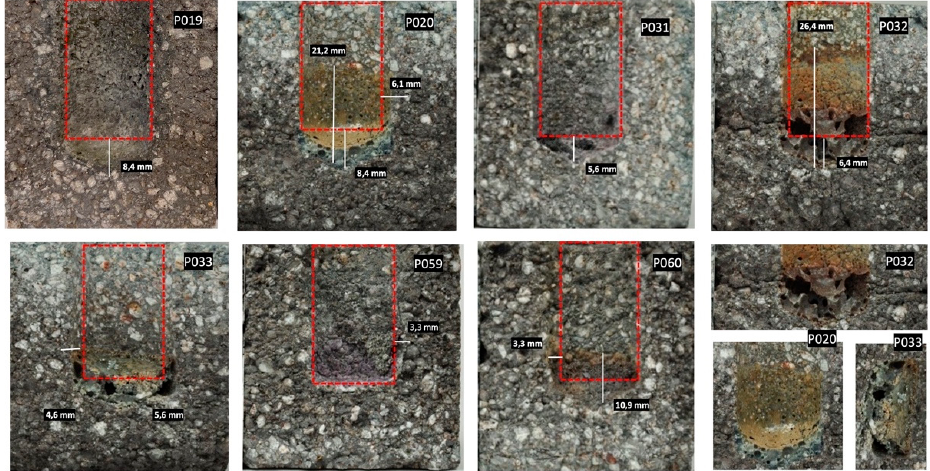
Figure 10. Corrosion of ARS60N quality refractory material with different types of wood ash with defined parameters of crucible test; 2.9 g ash/2 h/1200 °C.